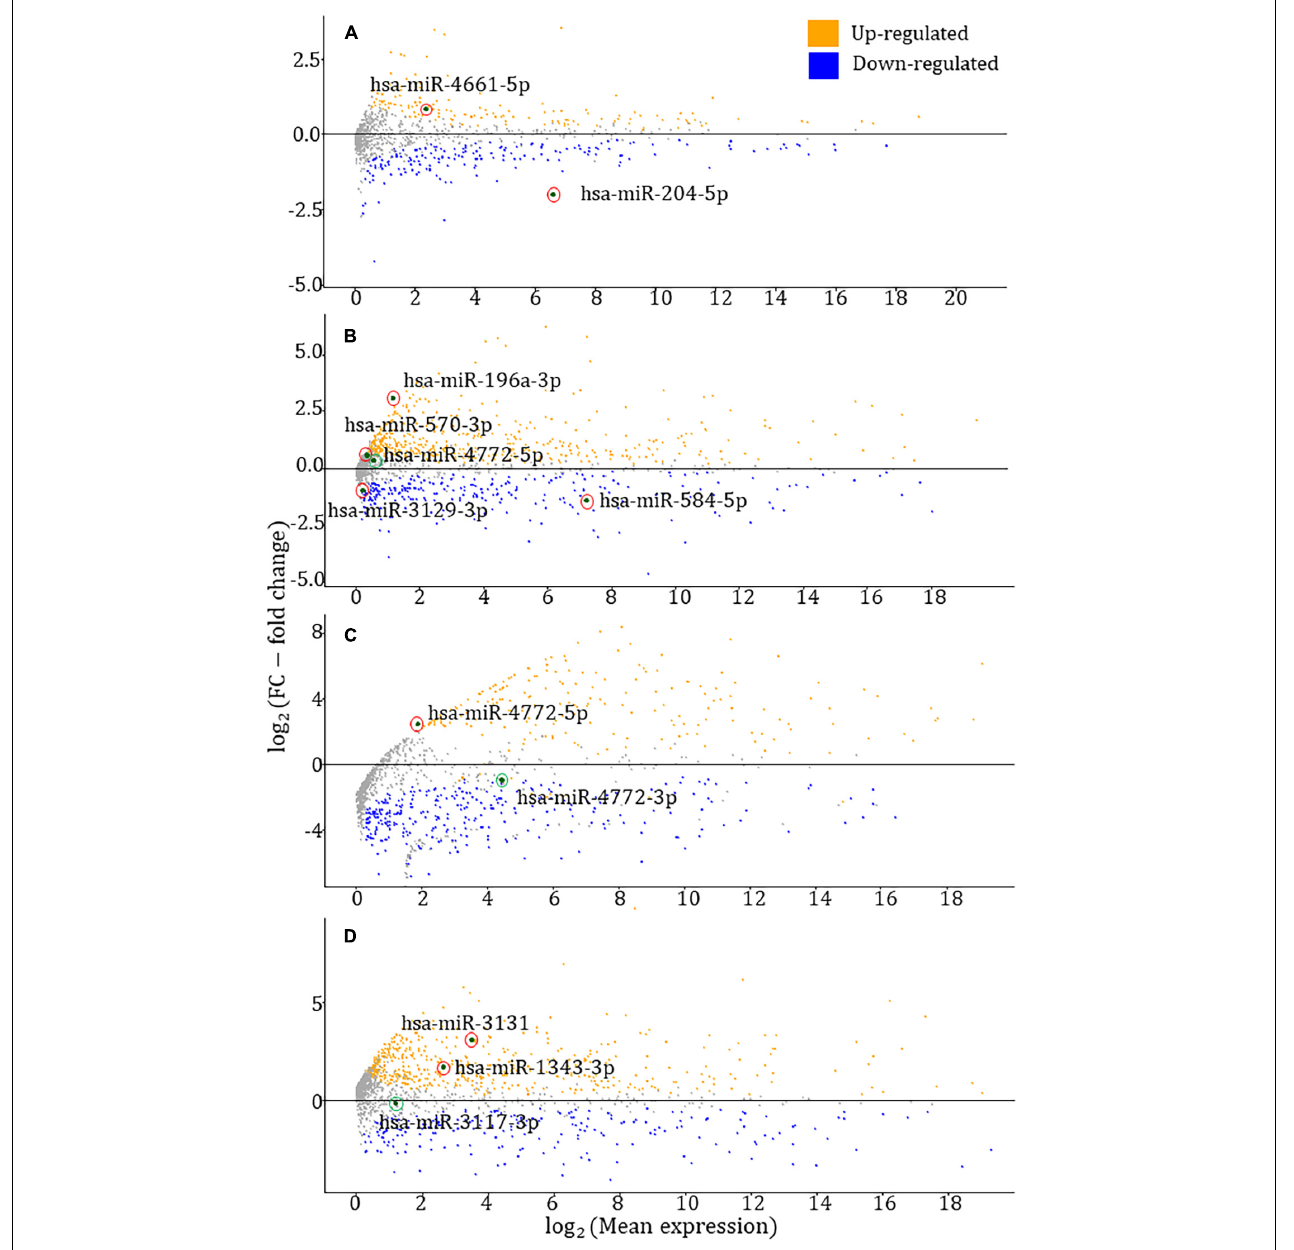
FIGURE 3 | MA plots for the differential expression analysis of TWAS-identified miRNAs. (A–D) MA plots for prostate, breast, colorectal, and endometrial cancers, respectively. The red and green circled data points represent statistically significant [false discovery rate (FDR) < 0.05)] and insignificant (FDR ≥ 0.05) miRNAs from the DESeq2 differential expression analysis (Love et al., 2014). According to the four figures in the panel, six miRNAs have shown upregulations, whereas three miRNAs have exhibited